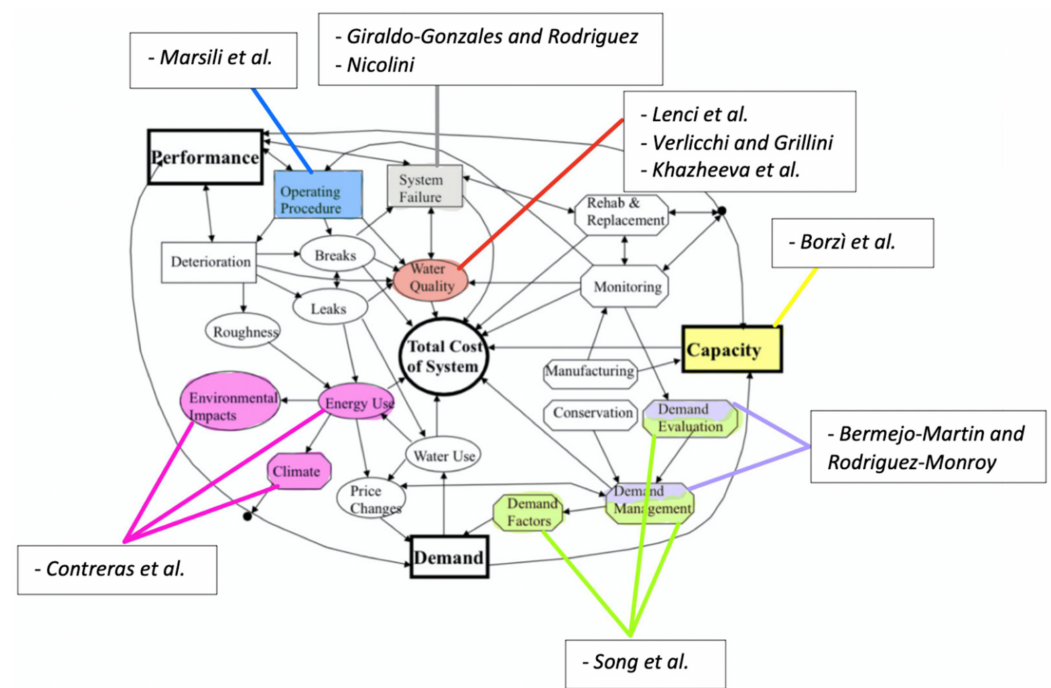
Figure 1. The labyrinth of the Urban Water Systems (modified from